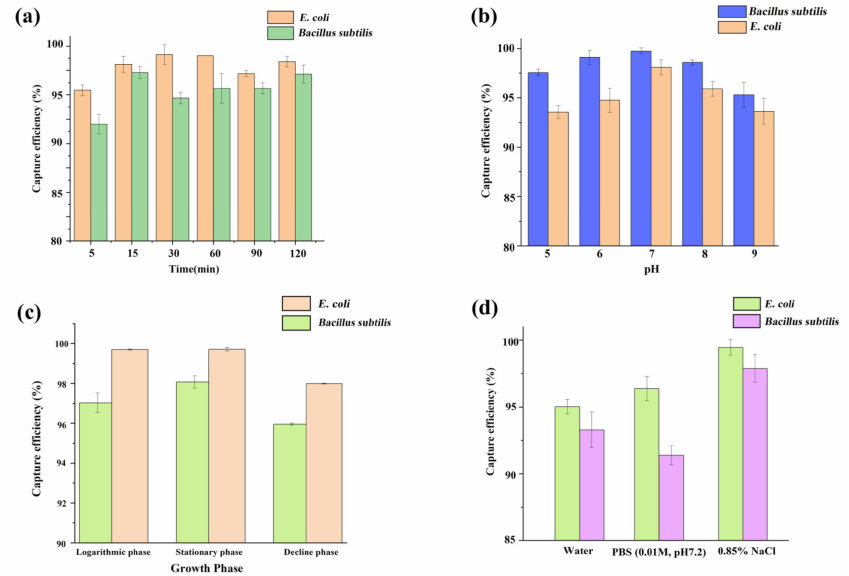
Figure 11. Effects of ( a ) incubation time, ( b ) pH, ( c ) growth phases, and ( d ) salinity on the capture